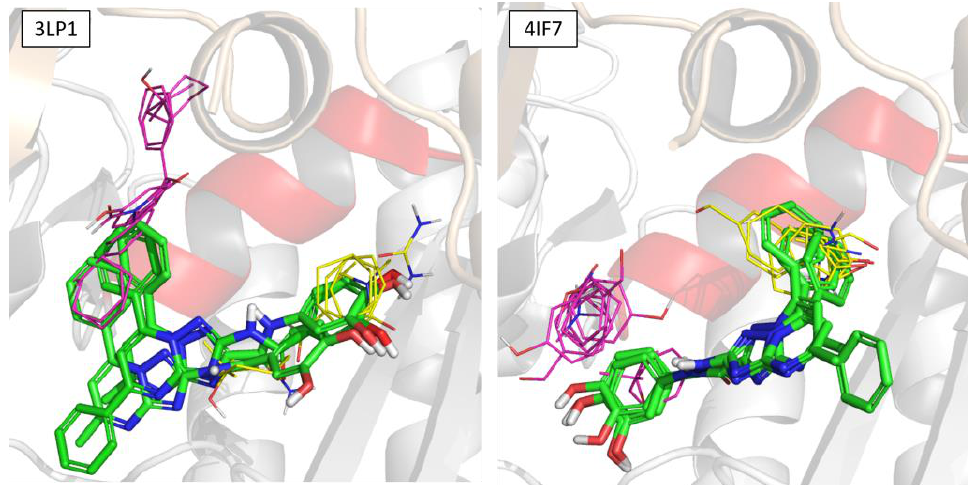
Figure 4. Superimposition of docking poses for derivatives 12g , 15g , and 18g (green) for 3LP1 and 4IF7 proteins. Magenta lines, Hs1 probes; yellow lines, Hs2 probes; red cartoon, α-helix 14.